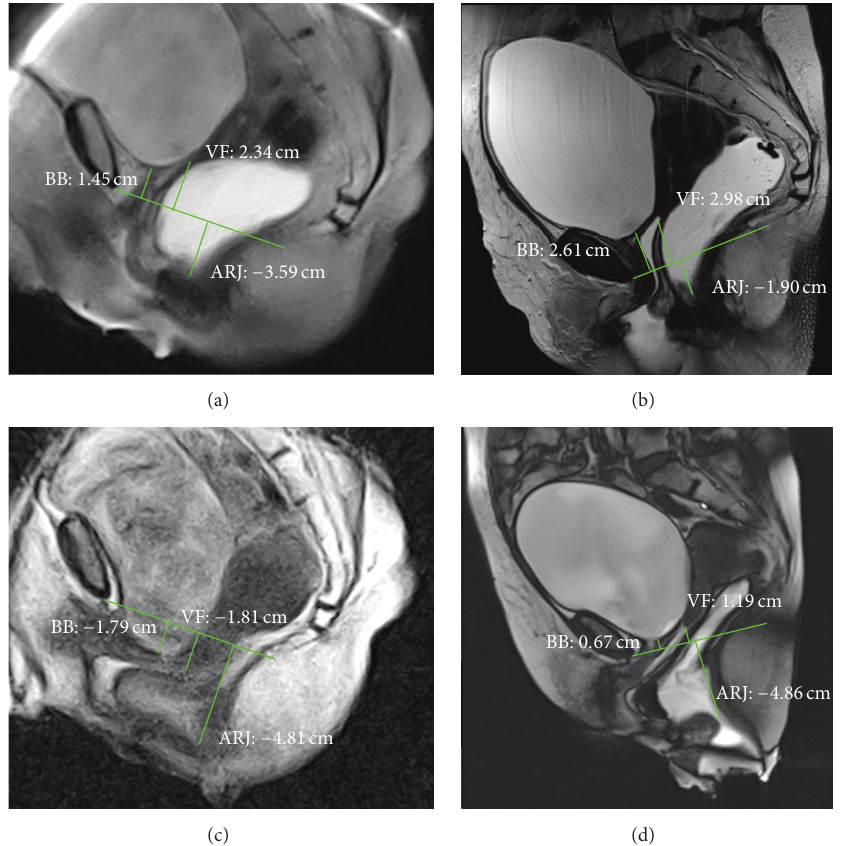
Figure 2: MR Defecography. Rest phase in sitting (a) and supine (b) position. Evacuation phase in sitting (c) and supine (d) position. The pathological fixed descent was detected only in sitting position in rest phase (a). In evacuation phase, a cystocele became evident (d), whereas the maximal descent of the ARJ is similar in both sitting and supine position (c, d). BB: bladder base; VF: vaginal fornix; ARJ: anorectal